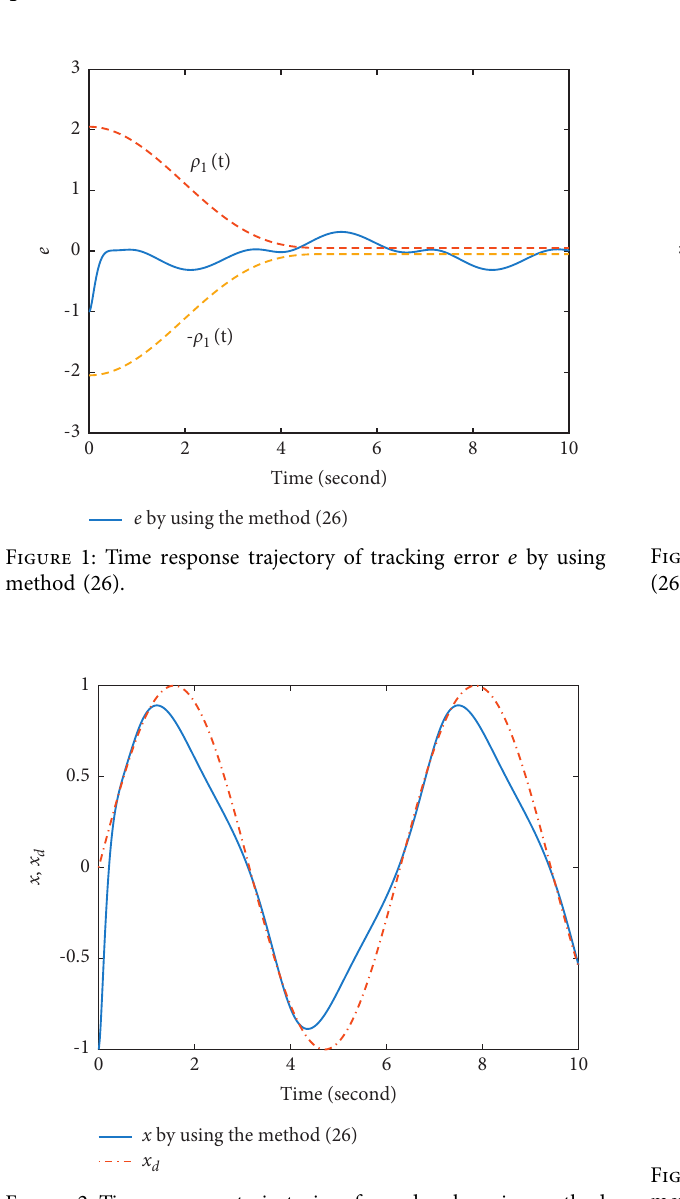
d by using method